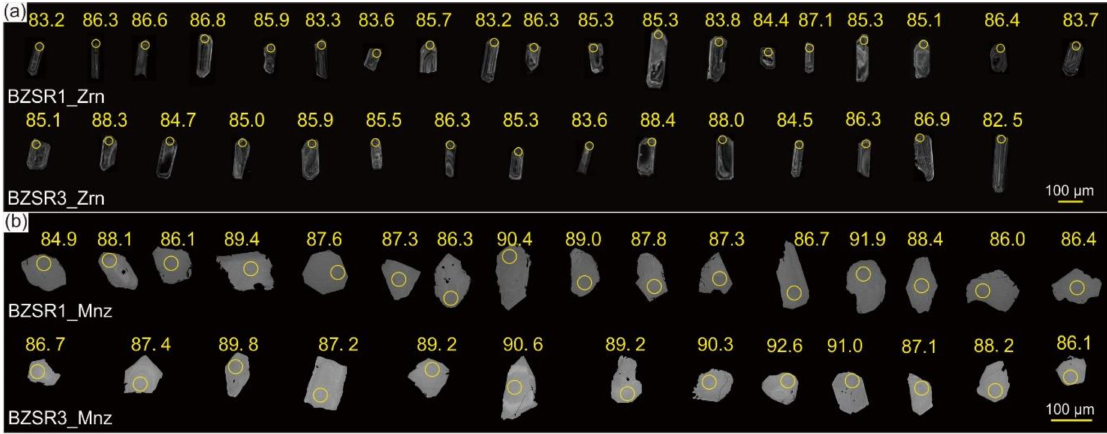
Figure 4. Cathodoluminescence (CL) images of analyzed zircons ( a ) and monazites ( b ) from the Bozhushan batholith. Yellow circles and numbers represent the spots selected for laser ablation and the calculated 206 Pb / 238 U ages (Ma),